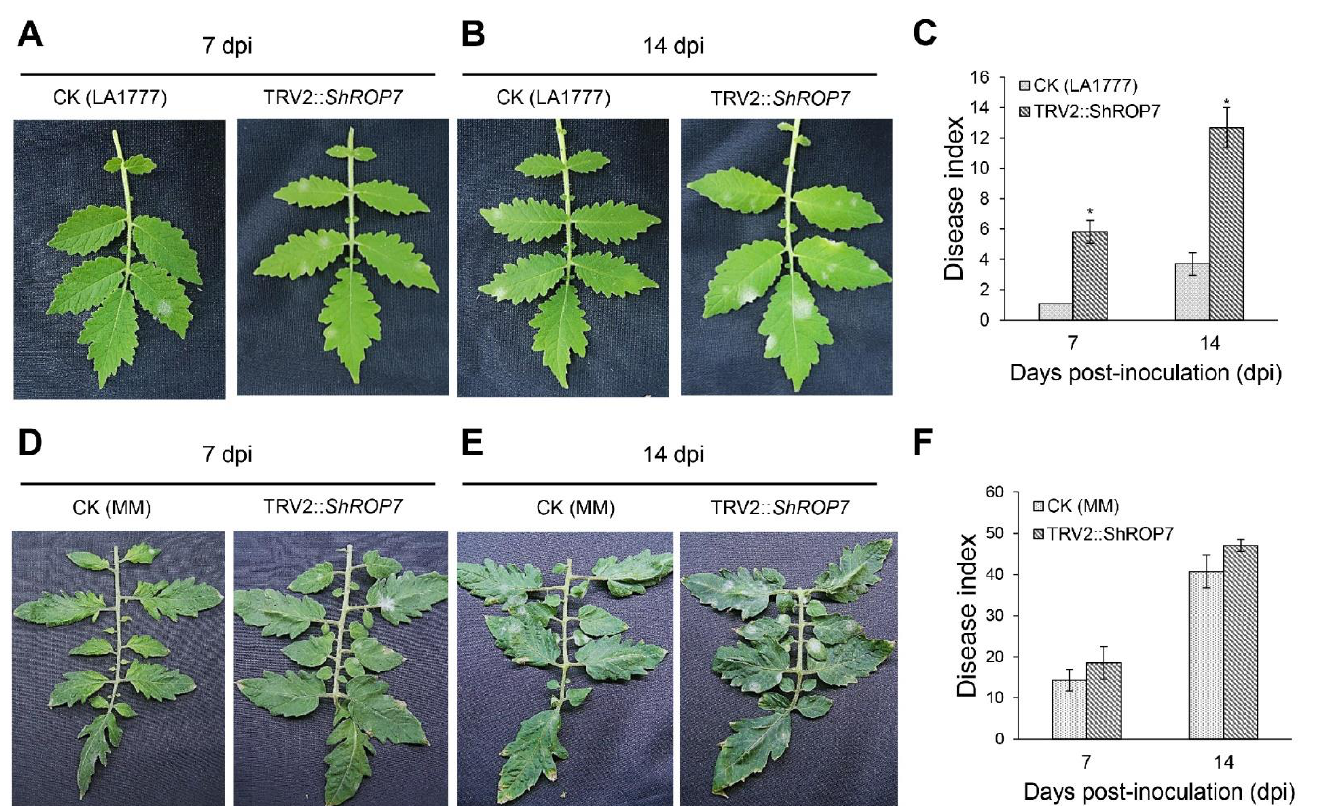
Figure 5. ShROP7 is required for resistance to powdery mildew. Genetic analysis of resistance response and disease development using TRV-induced gene silencing in tomato. Phenotypes of CK (control) and TRV2:: ShROP7 plants inoculated with On -LZ at 7 ( A ) and 14 ( B ) dpi in LA1777 plants and at 7 ( D ) and 14 ( E ) dpi in MM plants. Disease index was calculated for CK and TRV2:: ShROP7 plants at 7 and 14 dpi in LA1777 ( C ) and MM ( F ) plants. The asterisk ( * ) indicate significant differences of disease index between control (CK) and TRV2:: ShROP7 plants ( p < 0.05).